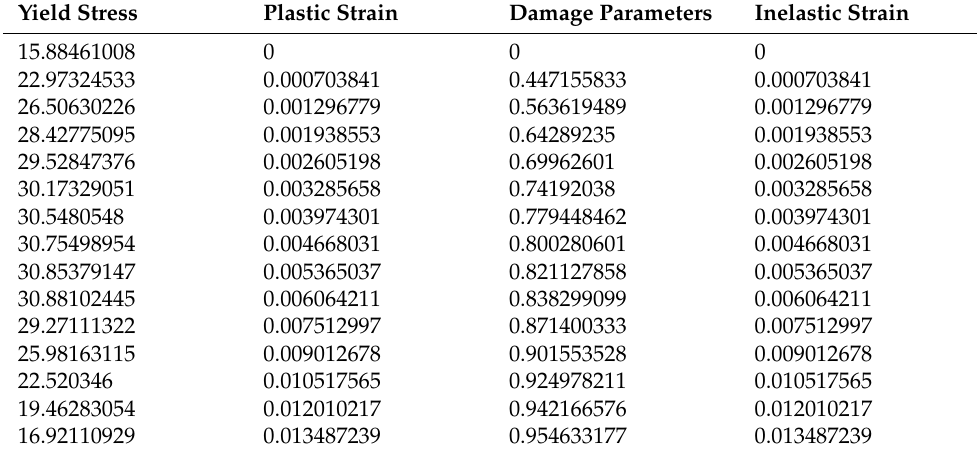
Table 7. Concrete compression damage.